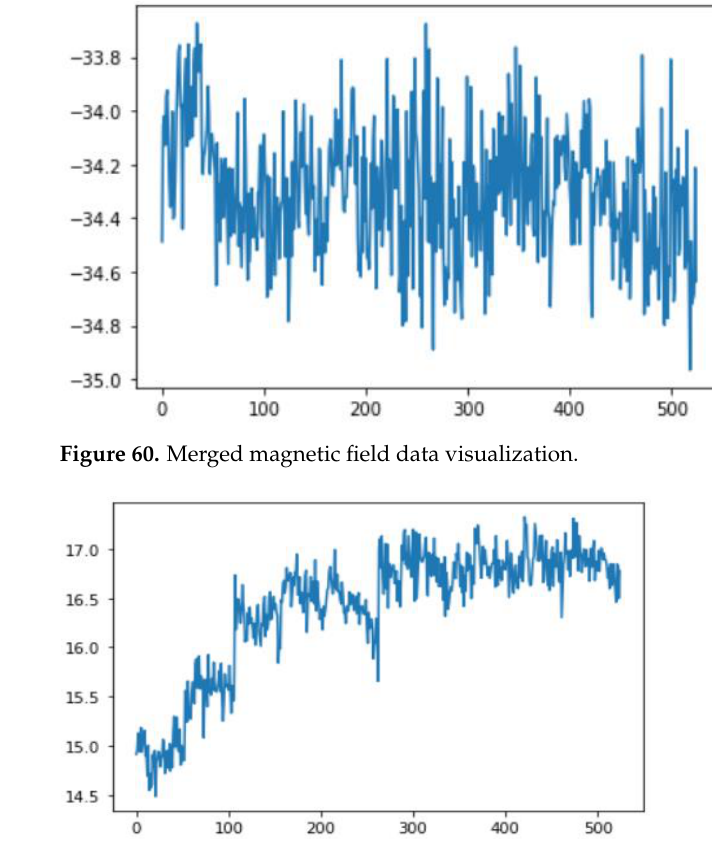
Figure 61. Continuous change in magnetic y -axis data.